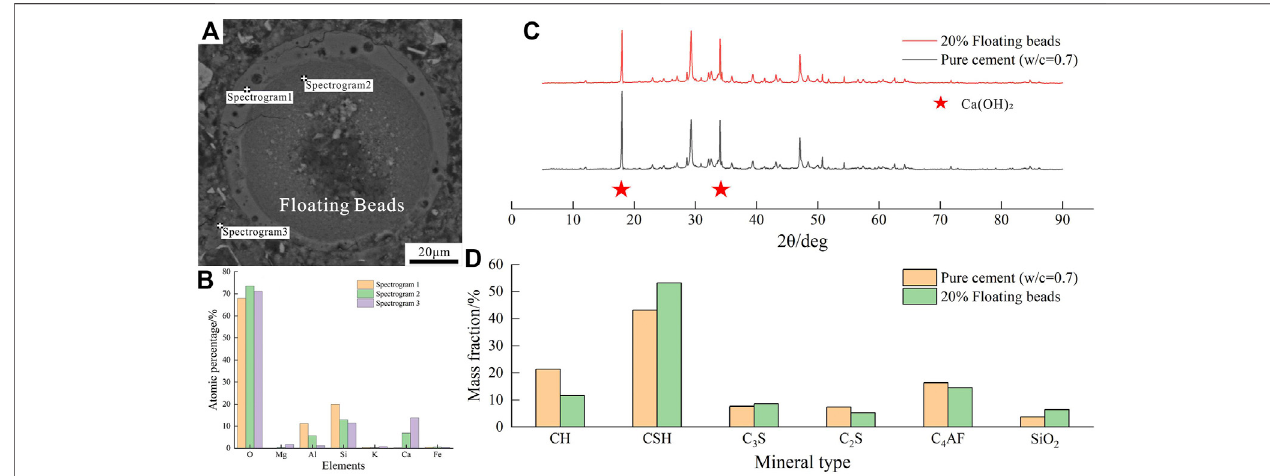
FIGURE 6 | Energy spectrum analysis and XRD results of thermal insulation cement with fl oating beads. (A) The selected points of spectrograms. (B) Atomic number statistics from energy spectrum analysis results. (C) XRD test results of pure cement (w/c = 0.7) and thermal insulation cement with 20% fl oating beads. (D) Mineral content statistics of XRD test